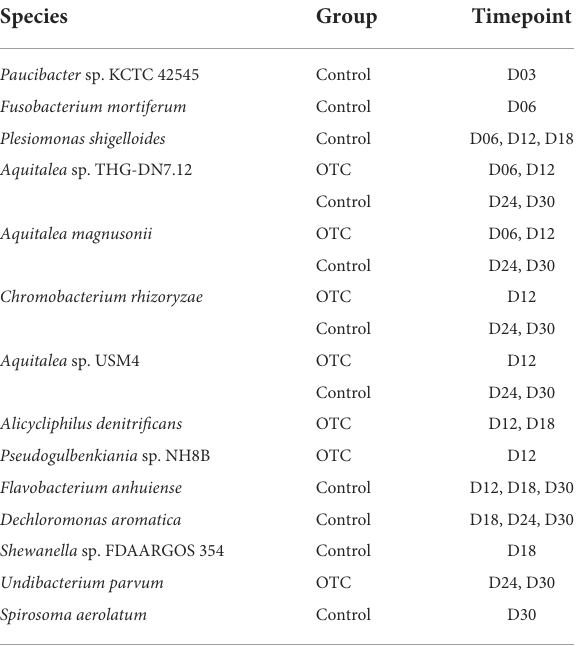
TABLE 2 Differentially abundant (enriched) microbial species identified using LEfSe (LDA score ≥ 4.0 as threshold). Species